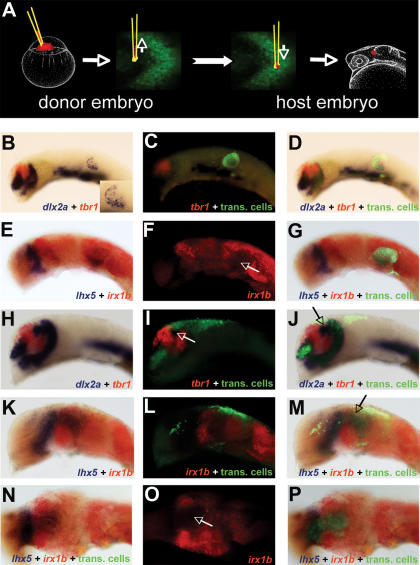
Transplantation of Prethalamic Precursors(A) Schematic overview of the transplantation experiment putting prethalamic precursors in ectopic regions of the neural plate.(B–D and H–J) shows dlx2a (blue), tbr1 (red), and transplanted cells in green; (E–G and K–P) shows lhx5 (blue), irx1b (red), and transplanted cells in green.(B–G) Transplanted cells located in the hindbrain show ectopic expression of the prethalamus markers dlx2a (B–D) or lhx5 (E–G); no expression of the telencephalon marker tbr1 (see inset in [B]) could be found in the clone. Cells do not exhibit expression of irx1b (arrow in [F]) in the transplanted cells.(H–P) After transplantation into the forebrain, ectopic cell–non-autonomous expression of dlx2a (arrow in [J]) could be seen (probably resulting in the split of the telencephalon, arrow in [I]) as well as of lhx5 in the thalamus (arrow in [M]). Cells did not switch on the expression of thalamic irx1b (arrow in [O]) in the thalamus.